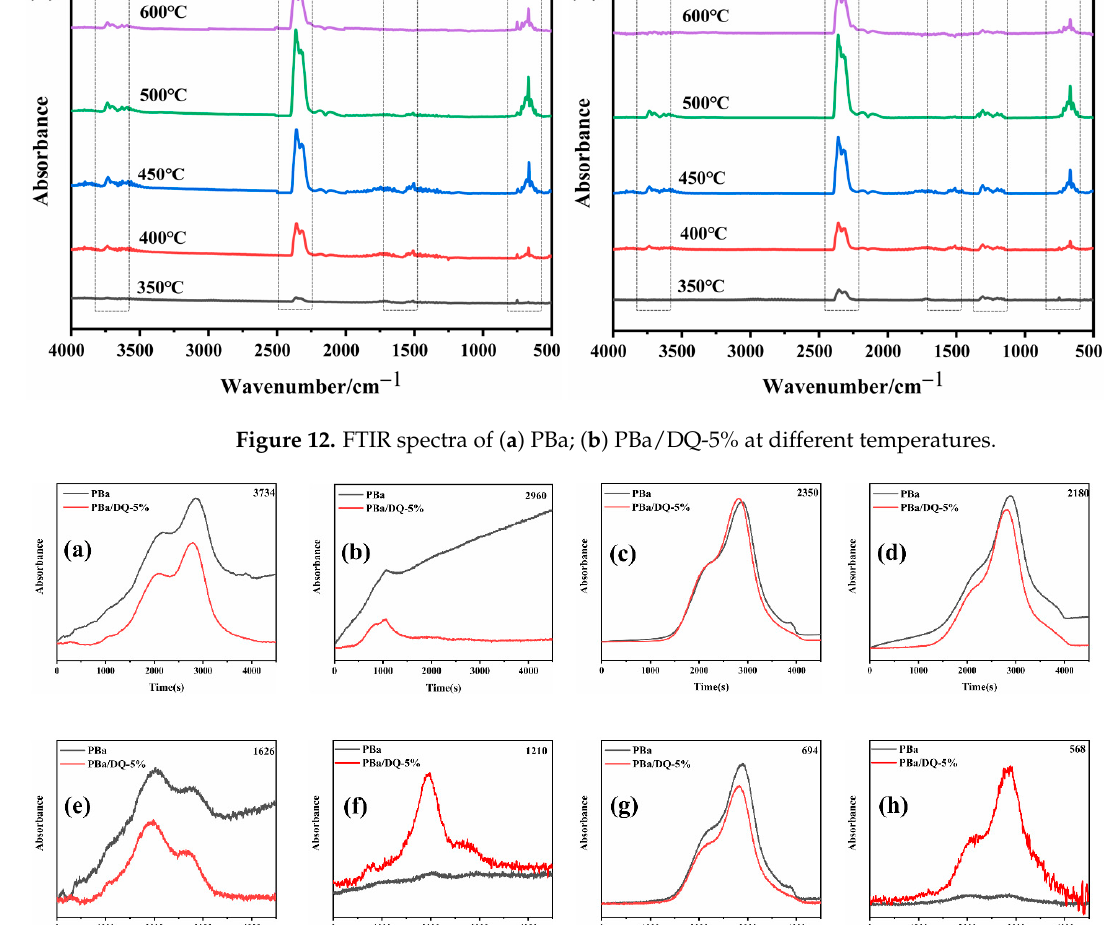
Figure 13. The analysis of pyrolysis products for pure PBa, PBa/DQ-5%: ( a ) water and ammonia gas; ( b ) alkane-containing compounds; ( c ) CO 2 ; ( d ) CO; ( e ) and ( g ) aromatic compounds; ( f ) and ( h ) P–O and P=O compounds.